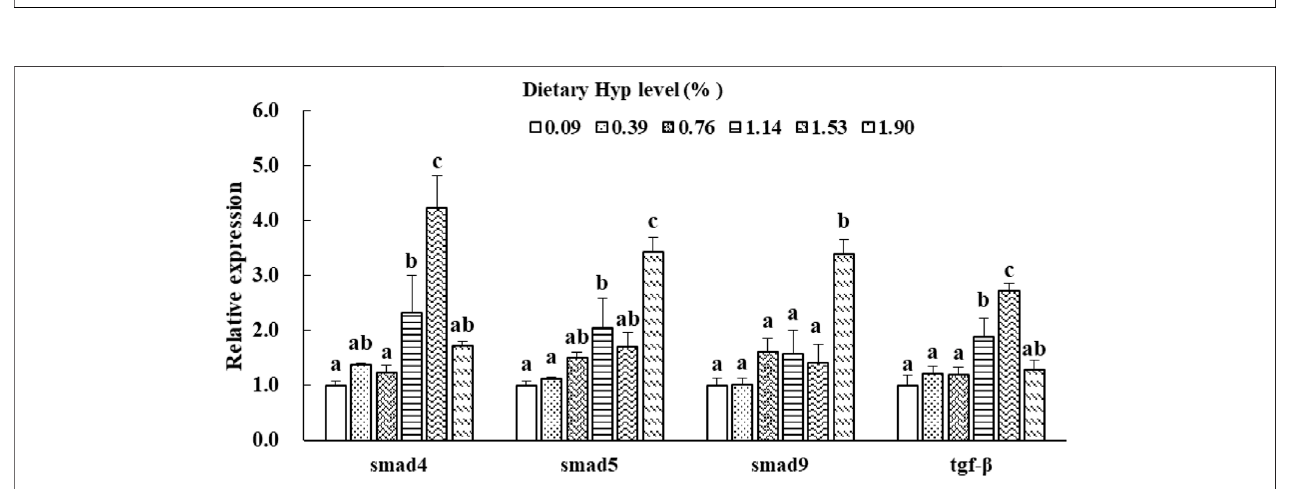
FIGURE 4 | Relative expressions of smad4 , smad5 , smad9 and tgf- β in muscle of ITCC fed with different experimental diets for 8 weeks. Data are present as Means ± SE (n = 6). Different lowercase letters above the same group of bars represent signi fi cant difference between the corresponding groups ( p < 0.05).